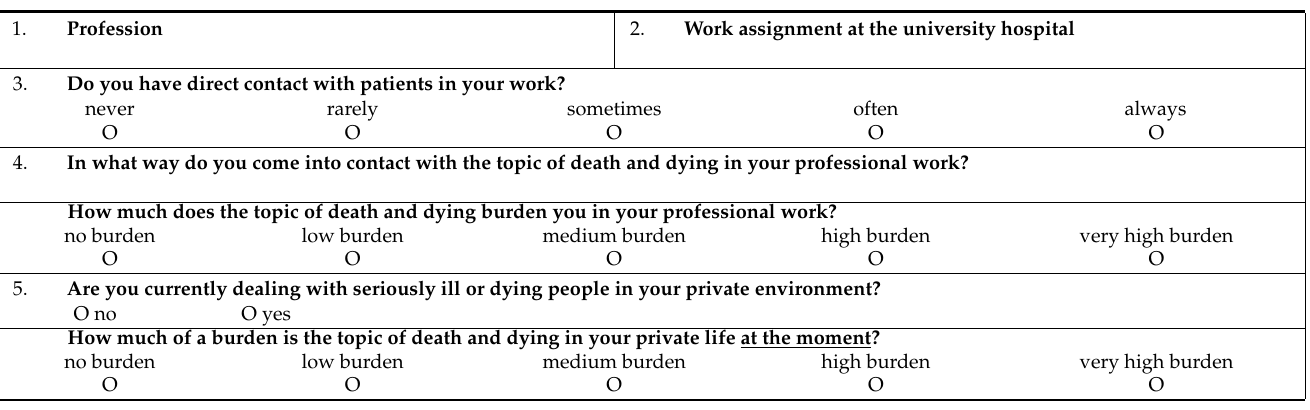
Table A2. Questionnaire “Last Aid” Courses 3–5 (translated from